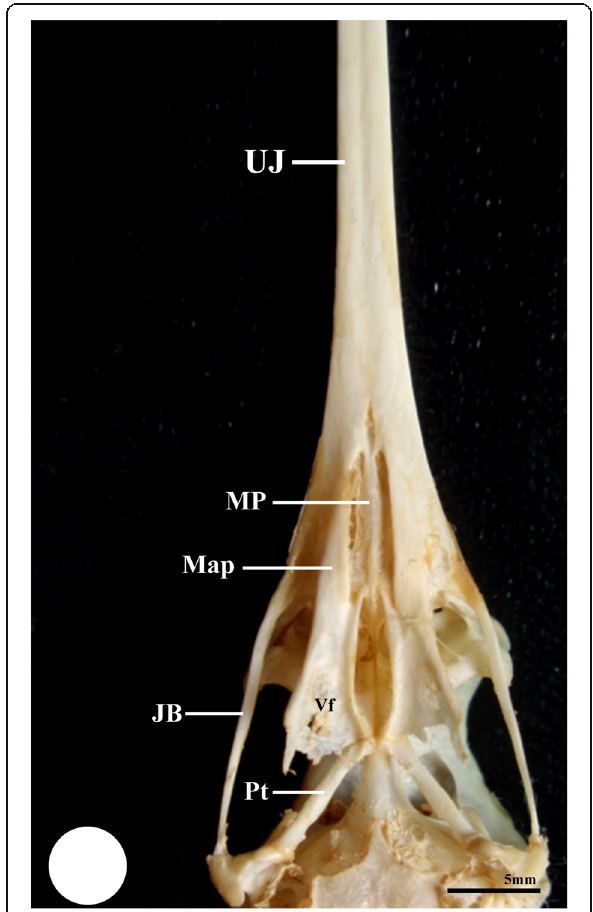
Fig. 5 Photomacrograph of ventral surface of skull of hoopoe shows upper jaw (UJ), Jugal bar (JB), the maxillary process of the palatine bone (Map), maxillopalatine process (MP), ventral fossa (Vf), Pterygoid (Pt), and parasphenoid